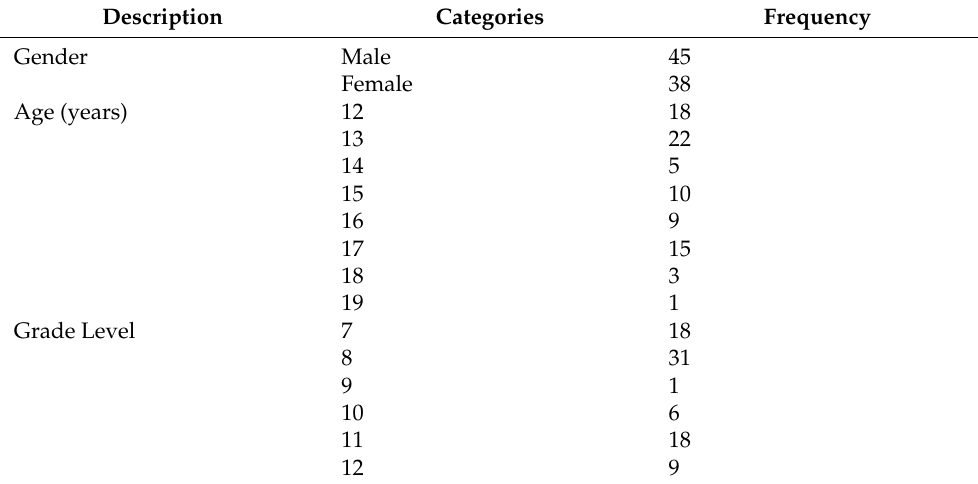
Table 3. Sociodemographic characteristics of respondents.